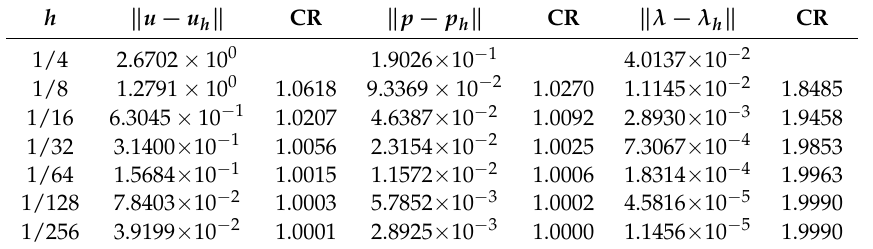
Table 7. Discrete errors and convergence rates for Example 2 at time T = 1 with δ t = 0.1 and nb = 2.